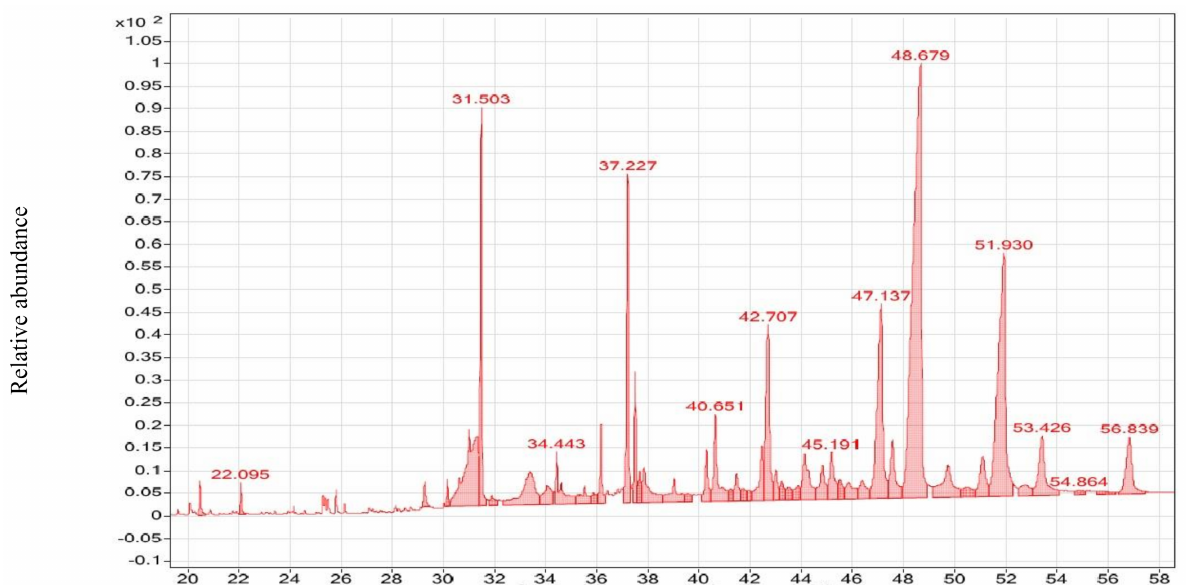
Figure 3. GC–MS chromatogram of Cs